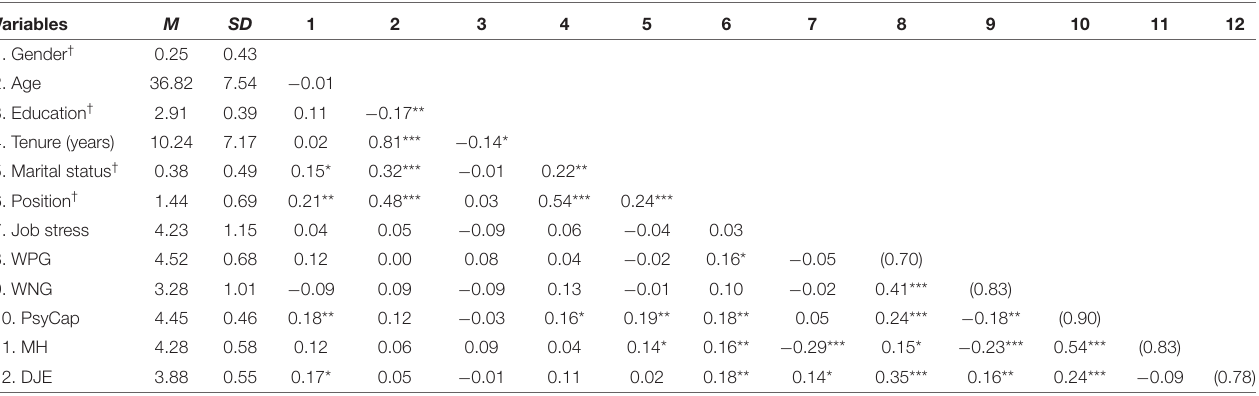
TABLE 1 | Variables means, standard deviations, reliabilities, and correlations ( N = 222). Variables